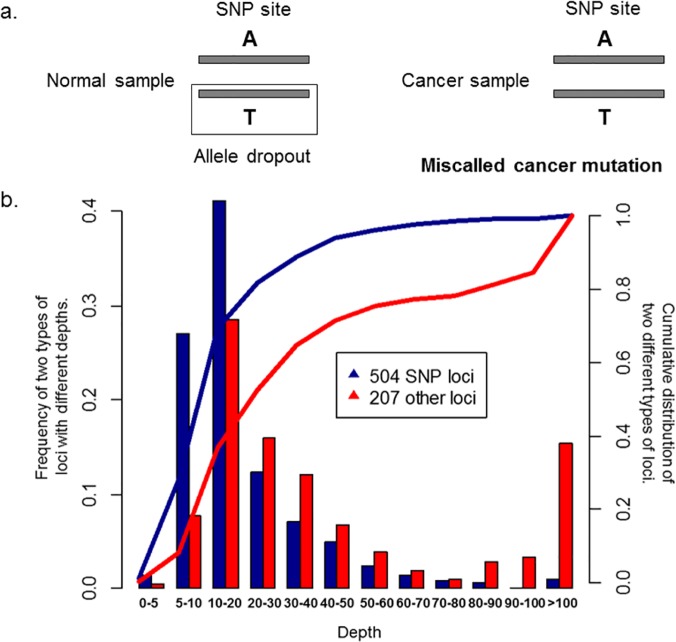
Miscalled cancer mutations in the original paper may due to allele dropout at SNP sites in the normal samples.
a. A SNP site in a normal sample could be wrongly considered to be homozygous by allele dropout, which leaded to miscall the site in cancer samples. b. The frequency distribution of sequence coverage of 711 sites (504 germ-line SNP sites: blue; 207 non-SNP sites: red) in normal tissues identified in the original paper. The curves (blue for germ-line SNP sites, and red for non-SNP sites) were accumulated distribution curves.